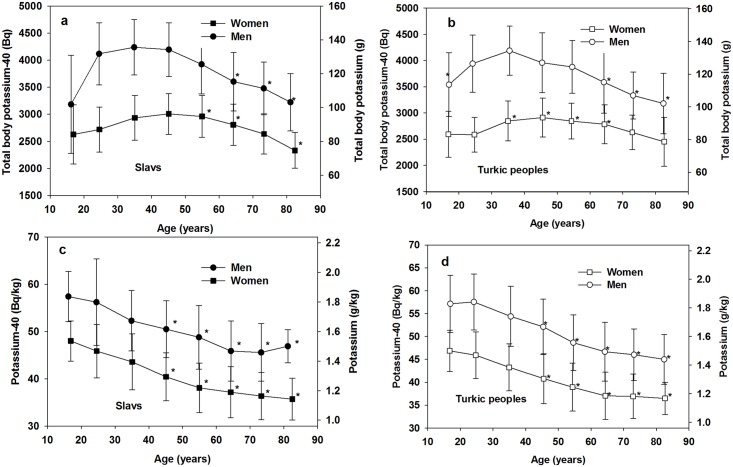
40K and stable potassium body contends in men and women depending on age gender and ethnicity.(a) Slavs, total body potassium and 40K; (b) Turkic peoples, total body potassium and 40K; (c) Slavs, body potassium g/kg and 40K Bq/kg; (d) Turkic peoples, body potassium g/kg and 40K Bq/kg. Bars represent the range of standard deviation. *—statistically significant differences from the value for the age group 20–30 of the respective gender (t-test; U-test).